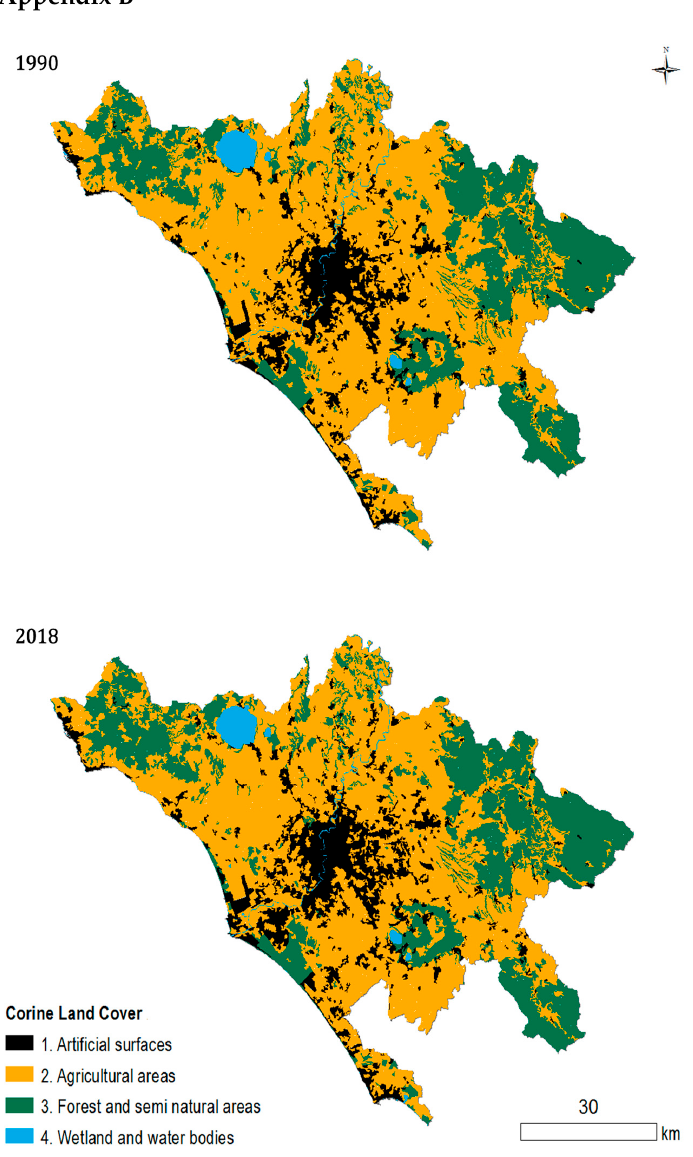
Figure A1. Land-cover and -use in 1990 and 2018. Source: CLC Figure 1. Land-cover and -use in 1990 and 2018. Source: CLC [72].